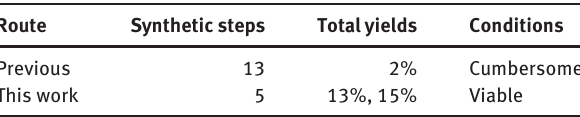
Table 1: Different synthetic route of (R)-2-benzyl-3-nitropropionic amide